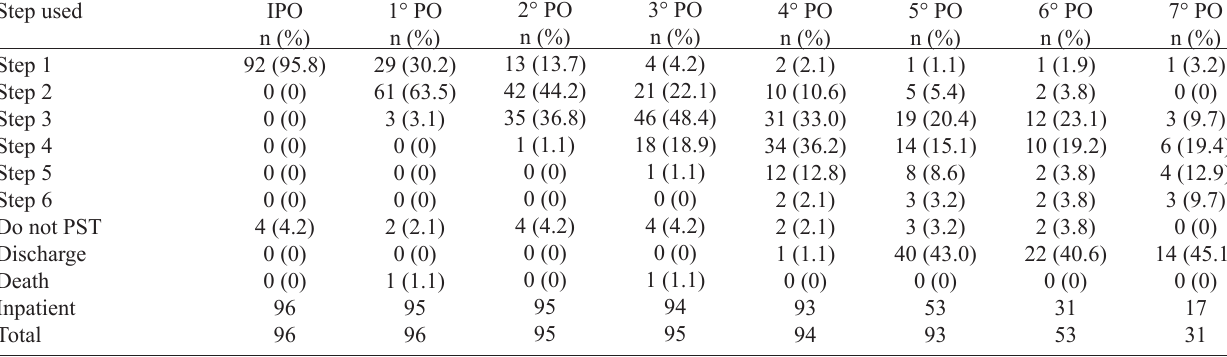
Table 3. Description of the Steps program used in the postoperative period of cardiac surgery (n =